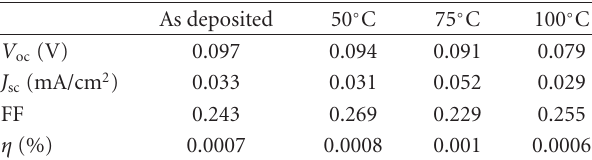
Table 2: Measured parameters of the solar